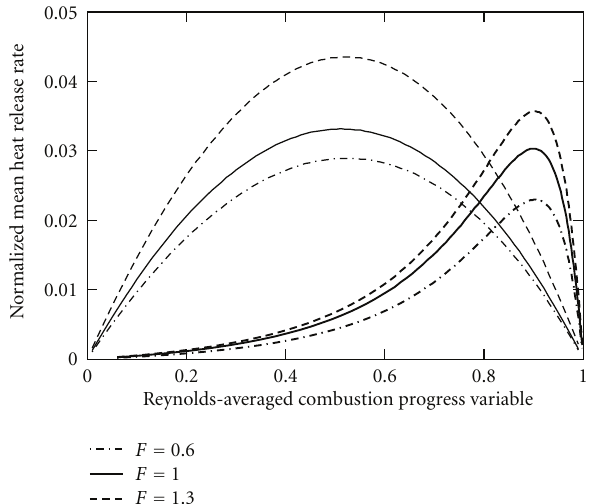
Figure 12: Dependencies of the normalized mean heat release rate on the Reynolds-averaged combustion progress variable, calculated for g = 0 . 9 and various equivalence ratios, specified in legends, by invoking the beta-function PDF. Thin and bold curves are associated with P ( c , c , c (cid:3) 2 ) and (cid:2) P ( c , (cid:2) c , ρc (cid:3)(cid:3) 2 /ρ ), respectively.